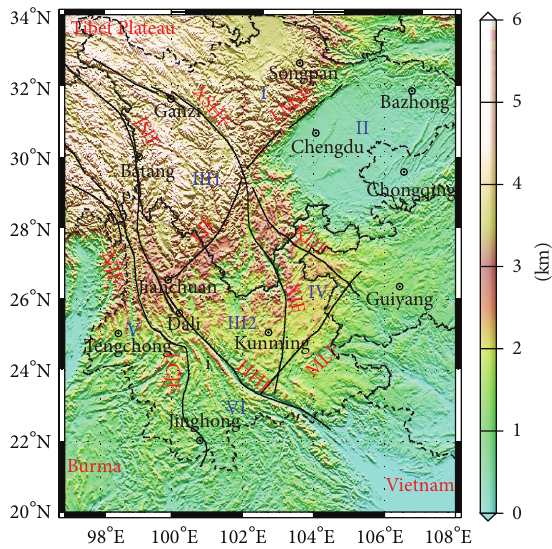
Figure 1: Schematic tectonic map of faults and blocks in the Sichuan-Yunnan region. Topographical data wereadded by courtesy of